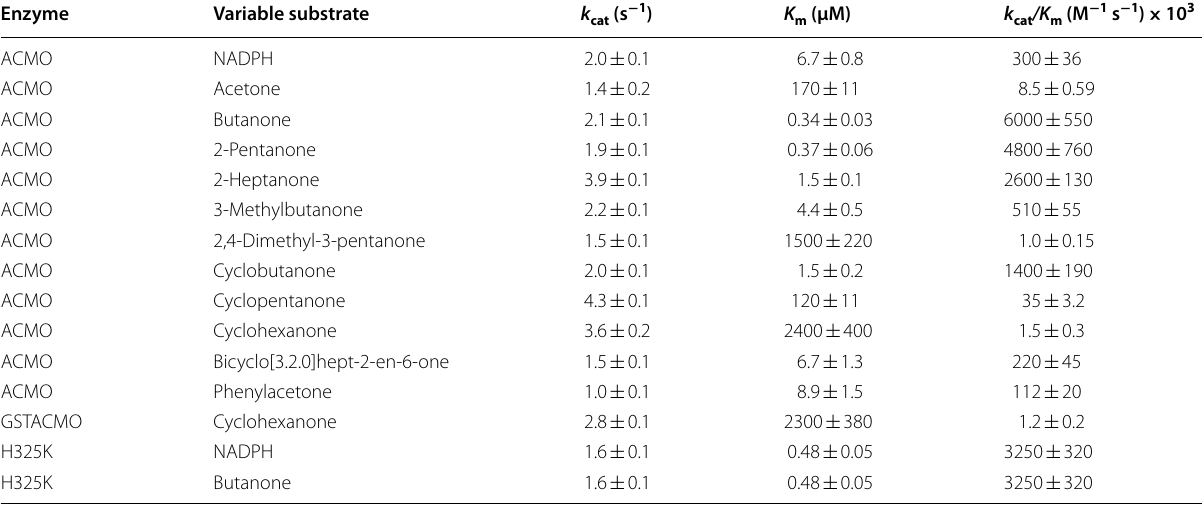
The experiments were performed in 50 mM HEPES–NaOH pH 7.5 at 25 °C as described in “Materials and methods”. Butanone was present at a fixed saturating concentration of 200 μM in steady-state experiments where NADPH served as the variable substrate. For experiments where the ketone served as the variable